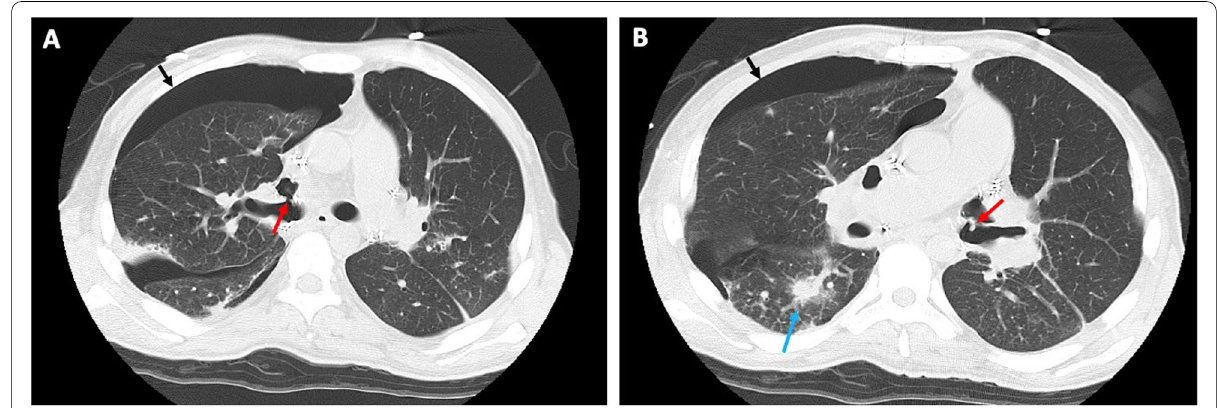
Fig. 1 A , B Images of computed tomography scan performed 15 days after the transplantation showing bronchial dehiscence (red arrows), pneumothorax (black arrows), and associated pneumonia (blue